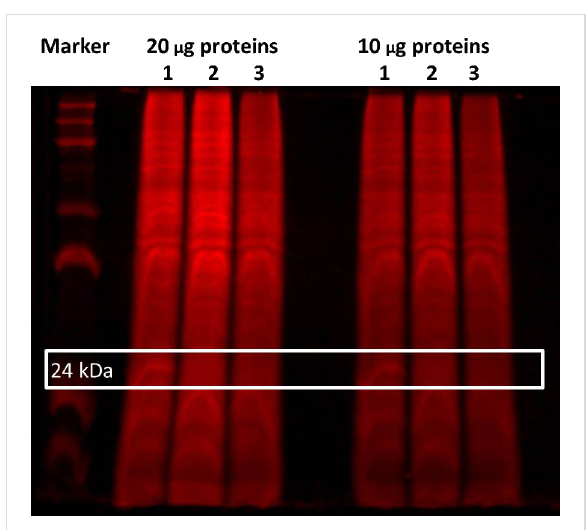
Figure 5: SDS-PAGE gel of photolabeling experiment in whole PC-3 cells. Lane 1 contains 0.3 µM 24 after 30 min UV treatment; lane 2 contains 0.3 µM 24 and 10 µM 29 after 30 min UV treatment; and lane 3 contains 0.3 µM 24 without UV